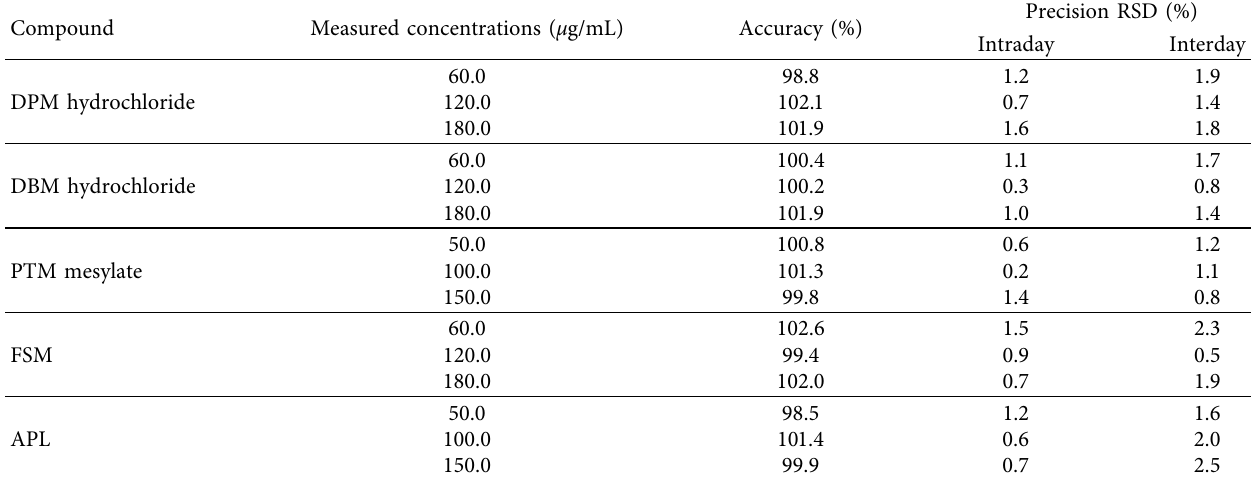
Table 2: Validation of HPLC method.